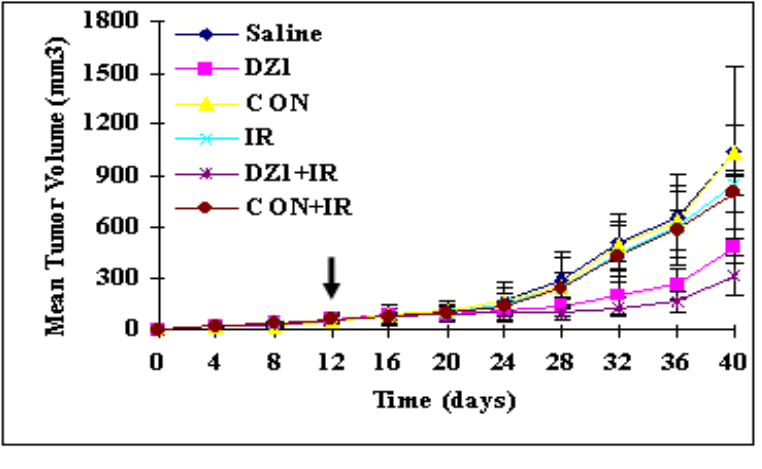
Figure 7. DZ1-mediated inhibition of tumor growth and enhanced radiosensitivity in vivo . Six mice per group were injected DZ1 intratumorally twice weekly and 5Gy irradiation treatments were performed.